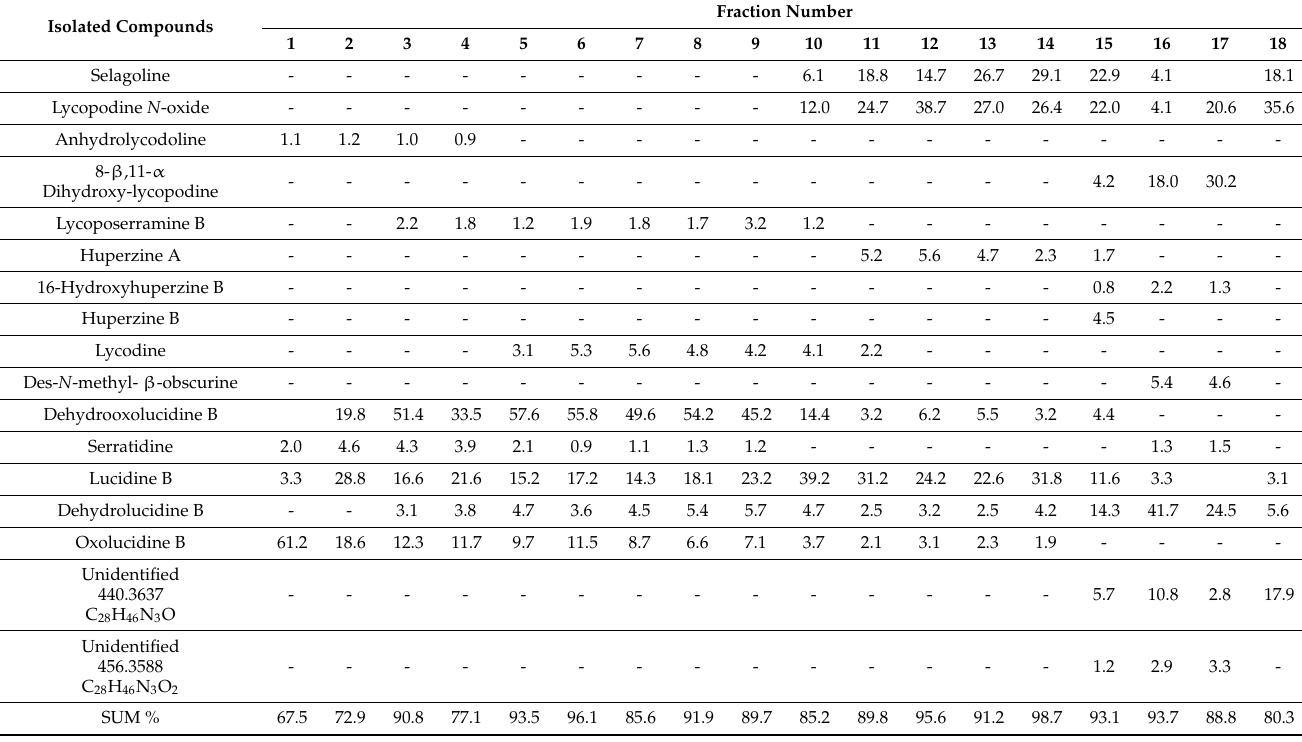
Table 5. Results of alkaloids identified via HPLC/ESI-QTOF-MS present in fractions 1–18 obtained from experiment 1 via VLC using sorbents Al 2 O 3 and silica gel in ratio 1:3 from H. selago extract. Isolated